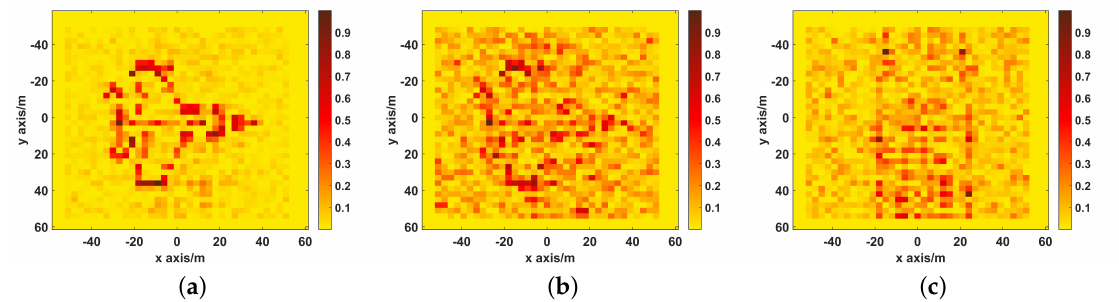
Figure 6. The imaging results of UPIM, DPDIM, and SPIM. ( a ) the reconstructed image by UPIM, the NMSE is 0.28; ( b ) the reconstructed image by DPDIM, the NMSE is 0.94; ( c ) the reconstructed image by SPIM, the NMSE is 1.21.